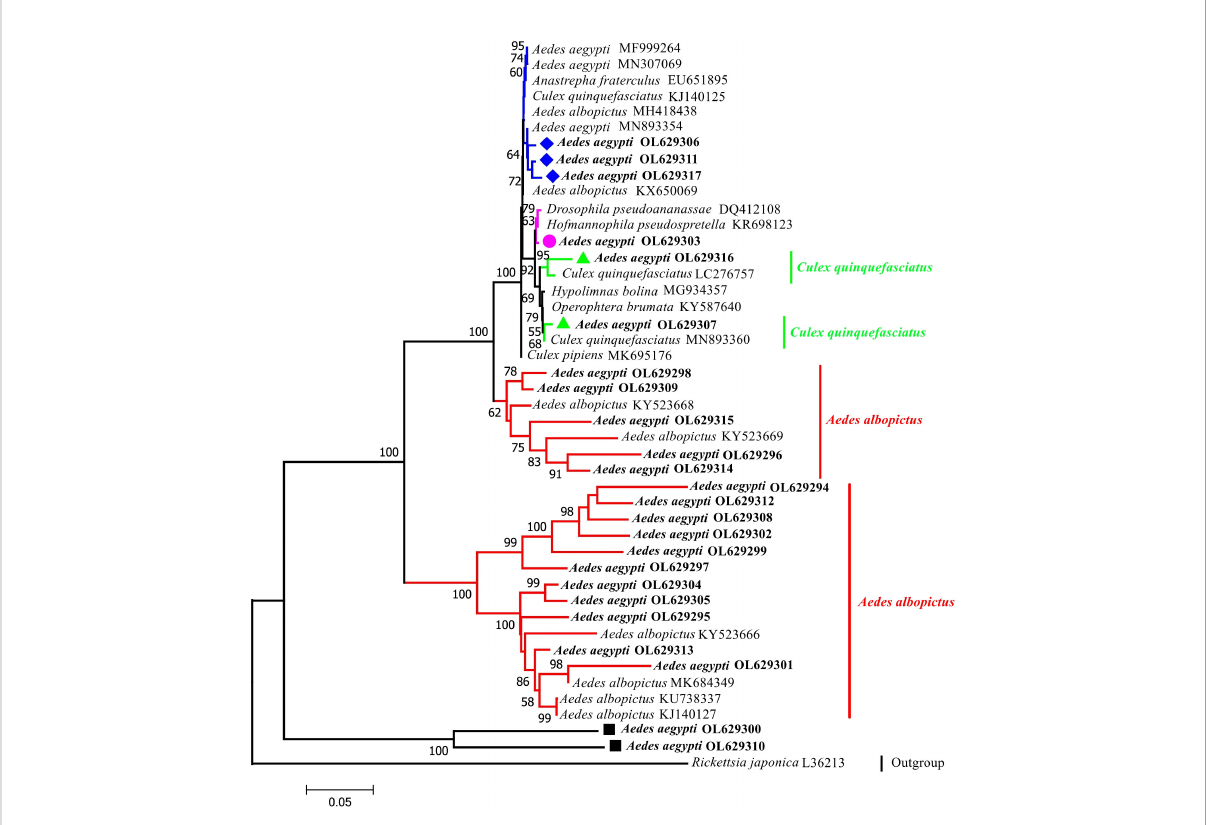
FIGURE 2 Phylogenetic tree analysis by the neighbor-joining method using the wsp gene (universal primers: 81F,691R). The tree contains 44 nucleotide sequences. 24 from this study; 19 from GenBank searches; 1 outgroup reference sequence ( Rickettsia japonica ) with Bootstrap values (1000 replicates) marked next to the branches. Taxa were tagged to obtain the host name of the Wolbachia strain and the ID in GenBank. the wsp sequences in this study all start with Aedes aegypti OL. OL629294 to OL629298 belong to JHGZ, Xishuangbanna prefecture. OL629299 to OL629301 belong to JHDM, Xishuangbanna prefecture. OL629302 and OL629303 belong to JHFZ, Xishuangbanna prefecture. OL629304 and OL629305 belong to JHML, Xishuangbanna prefecture. OL629306 and OL629307 belong to JHML, Xishuangbanna prefecture. OL629308 to OL629310 belong to DLAA, Xishuangbanna prefecture. OL629311 and OL629312 belong to DLXX, Xishuangbanna prefecture. OL629313 belongs to JHJL, Xishuangbanna prefecture. OL629314 to OL629316 belong to JGLS, Dehong prefecture. OL629317 belongs to RLJK, Dehong prefecture. The reference sequences used are shown in Table